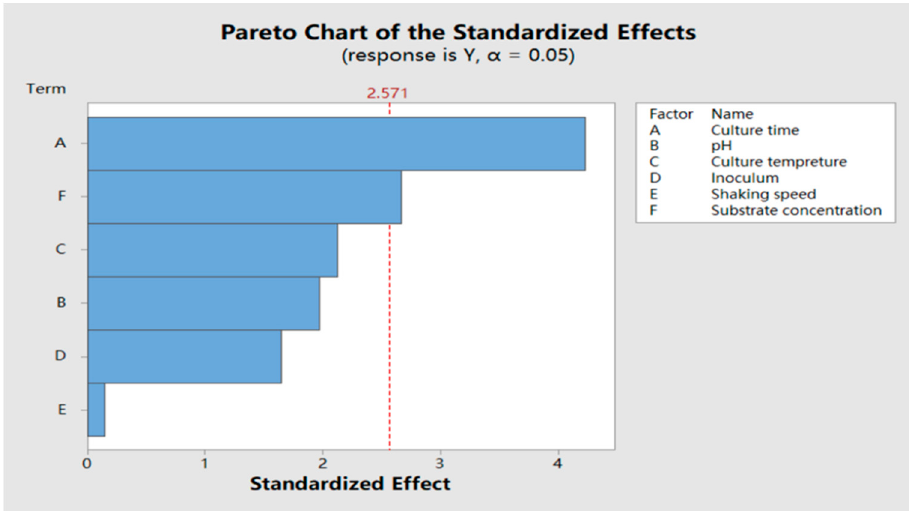
Figure 5. Pareto chart of standardized factors ( α = 0.05).